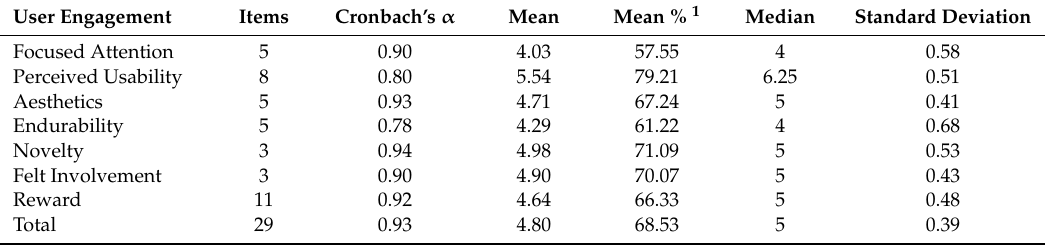
Table 2. Sub-scales of User Engagement (UE), number of items corresponding, and results of the analyses performed: Cronbach’s alpha, mean, mean %, median, and standard deviation. User Engagement Items Cronbach’s